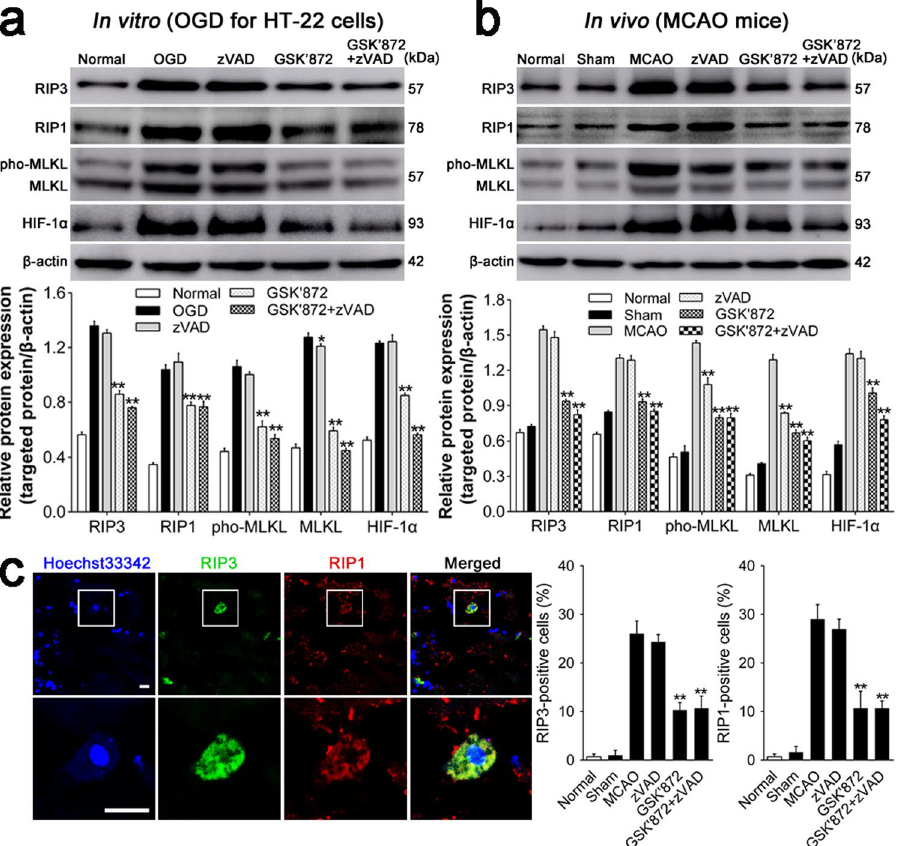
Figure 4. GSK’872 and combinative intervention downregulated HIF-1 α and necroptosis-associated proteins. ( a and b ) Relative protein expression in vitro and in vivo was detected by Western Blotting assay, measured as the ratio to β -actin, and analyzed using Scion Image 4.0 software. ( c ) (Left) Representative RIP3 (green) and RIP1 (red) staining co-localized in the plasma of the infarct region of mice. Nuclei were visualized with Hoechest33342. Scale bar = 10 μ m. (Right) Quantitative analysis of RIP3- or RIP1-positive cells. Data are reported as the mean ± SD. * p < 0.05, ** p < 0.01 vs . OGD or MCAO